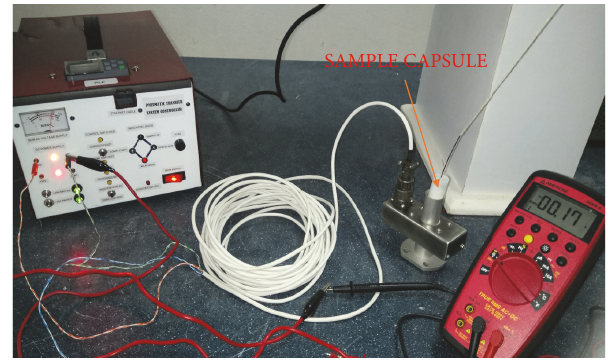
Figure 18: Sample capsule moved out of detection and phototransistor outputs 0.00